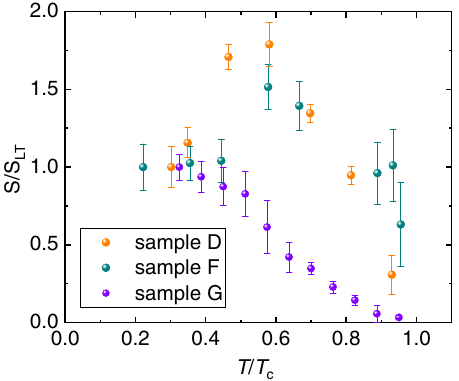
Fig. 3 Temperature dependence of the supercurrent diode effect. The graph shows the temperature dependence of S ≡ Q / B z for sample D, F, and G. S is evaluated from linear fi ts of Q ( B z ) near B z = 0, i.e. in the linear regime of the supercurrent recti fi cation ef fi ciency, where Q ∝ B z . The error bars correspond to the standard error of the fi ts. The S values are normalized to the lowest temperature value S LT (e.g. 17.2 T − 1 for sample G), while the temperatures are normalized to the critical temperature T c of the corresponding sample. Orange, blue and purple symbols refer to sample D, F and G, where the critical temperature of the constriction region is 4.3 K, 2.25 K and 4.0 K,